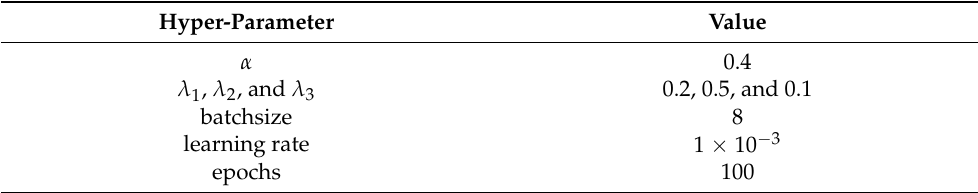
Table 2. This table describes the detailed setting values of different parameters during implementation. The α is the parameter in L oss cline (see Equation (10)), and λ 1 , λ 2 , and λ 3 are hyper-parameters in L oss (see Equation (14)). The settings of batchsize, learning rate, and epoch during training stage are also shown in the table.